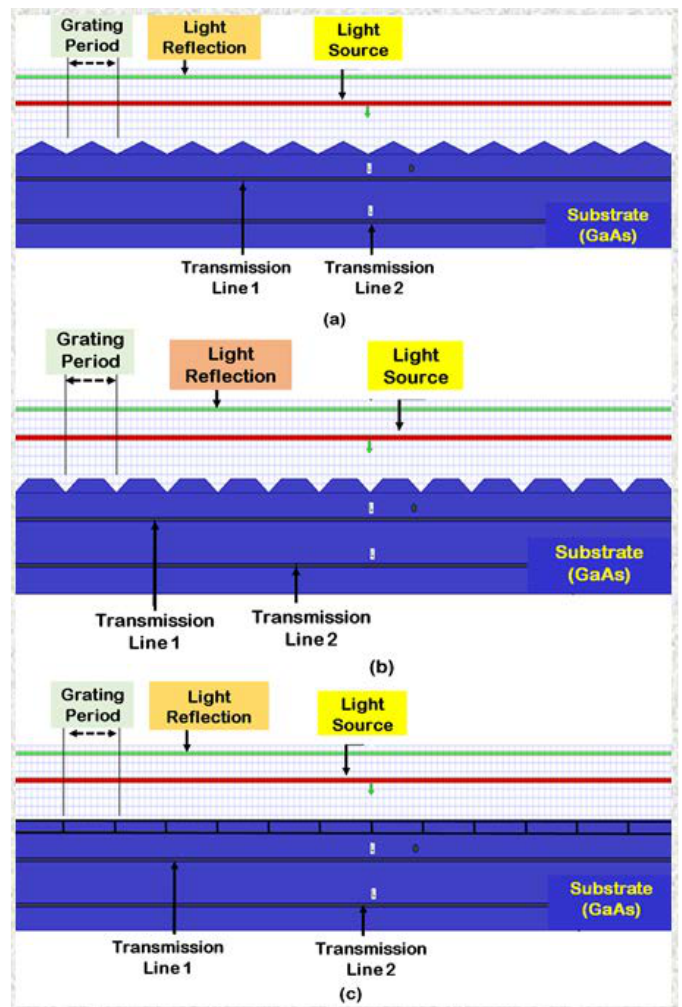
Figure 4. Simulation plane diagrams of ( a ) triangular-shaped nano-gratings with the aspect ratio of zero, ( b ) trapezoidal-shaped nano-gratings with the aspect ratio of 0.5 and ( c ) rectangular-shaped nano-gratings with the aspect ratio of one, on top of the semiconductor (GaAs) substrates.